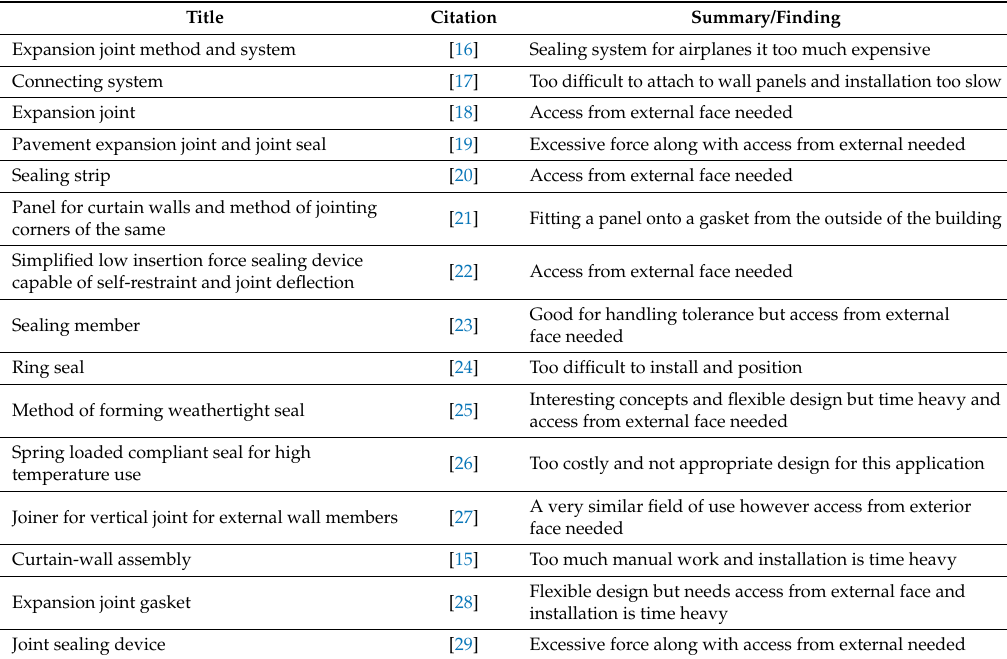
Table 1. Findings of Patent